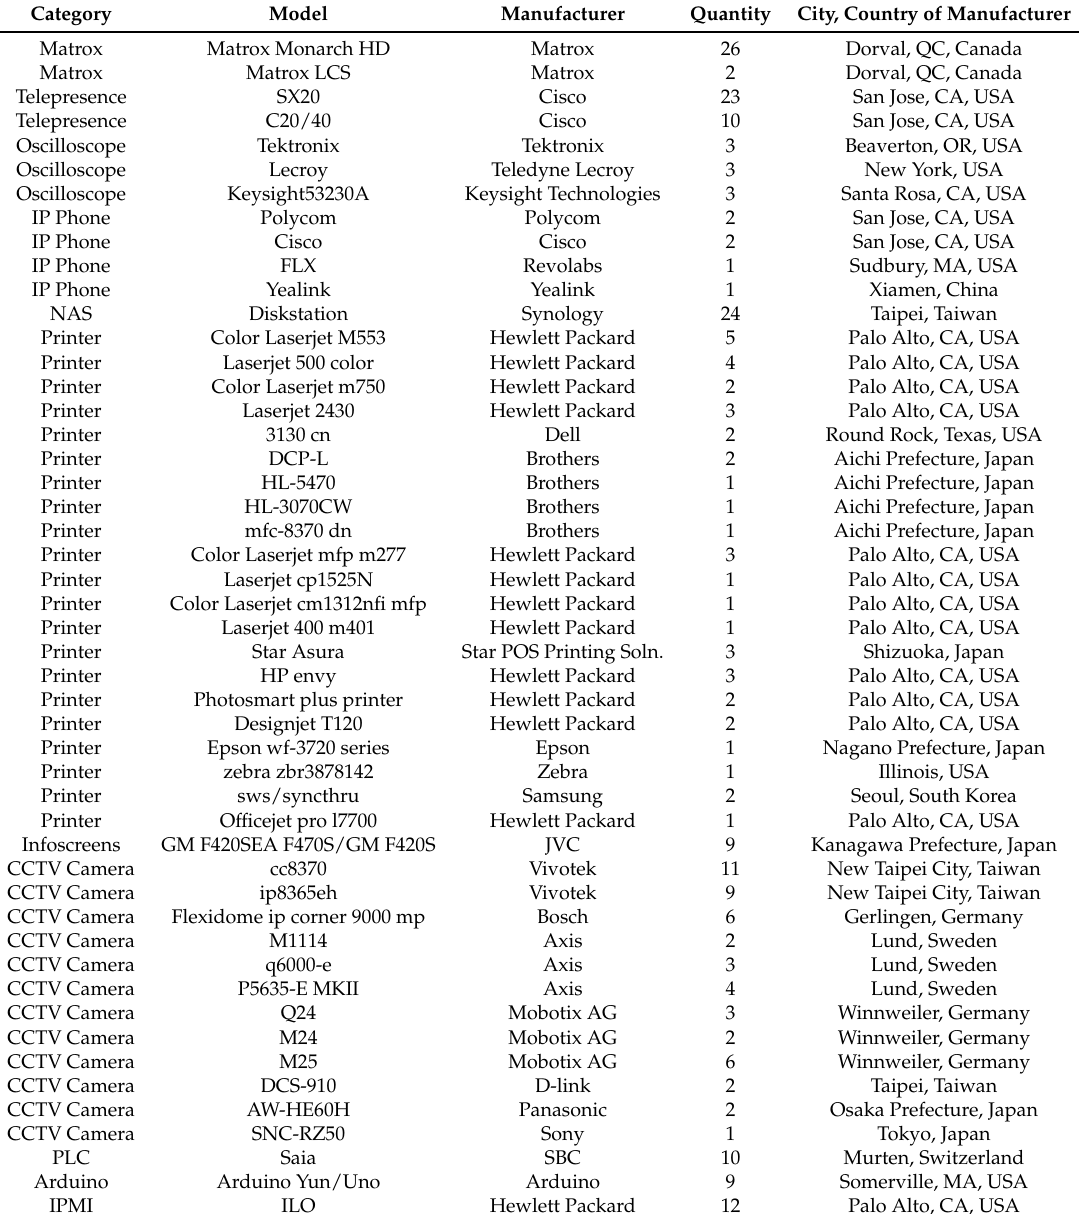
Table 1. Devices detected by